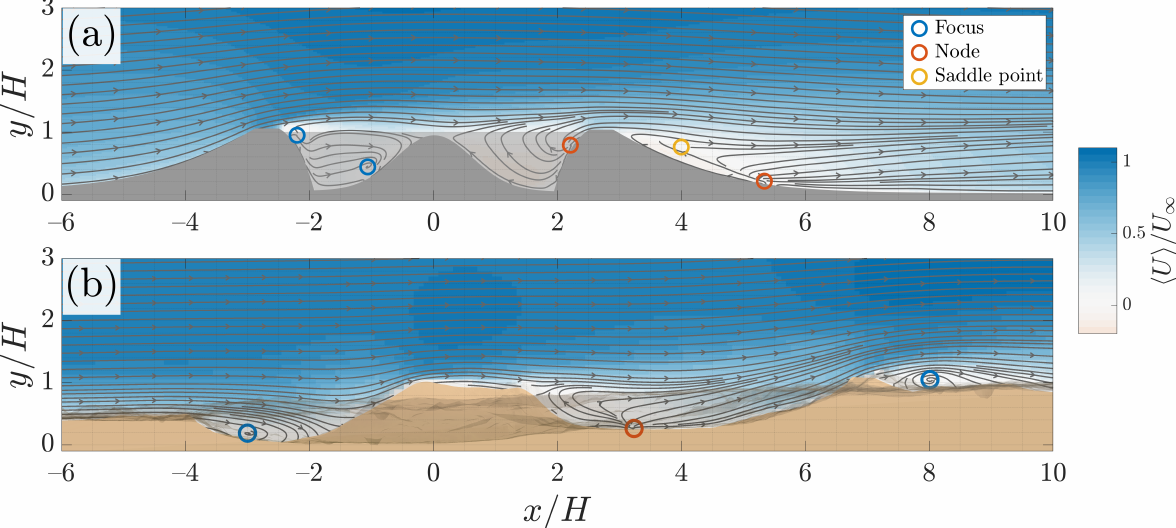
Figure 19. Contours of the in-plane mean streamwise velocity (cid:104) U (cid:105) normalized by free-stream velocity U ∞ for the ( a ) idealized crater model ( Re H = 8.9 × 10 3 ) and ( b ) Gale Crater model ( Re H = 4.6 × 10 3 ). Critical points are also shown in a similar manner as Figure